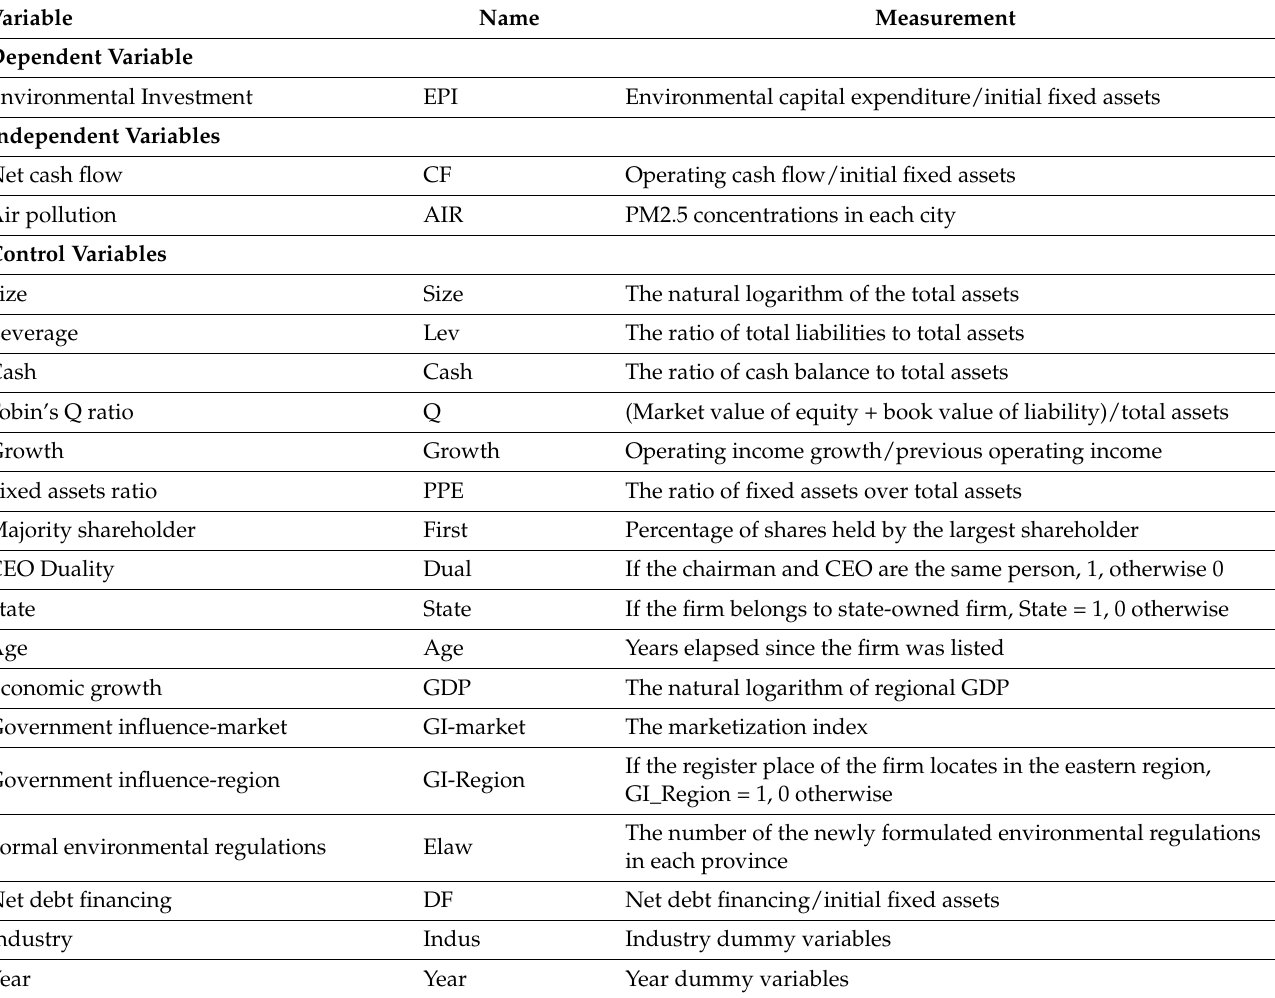
Table 1. Variable